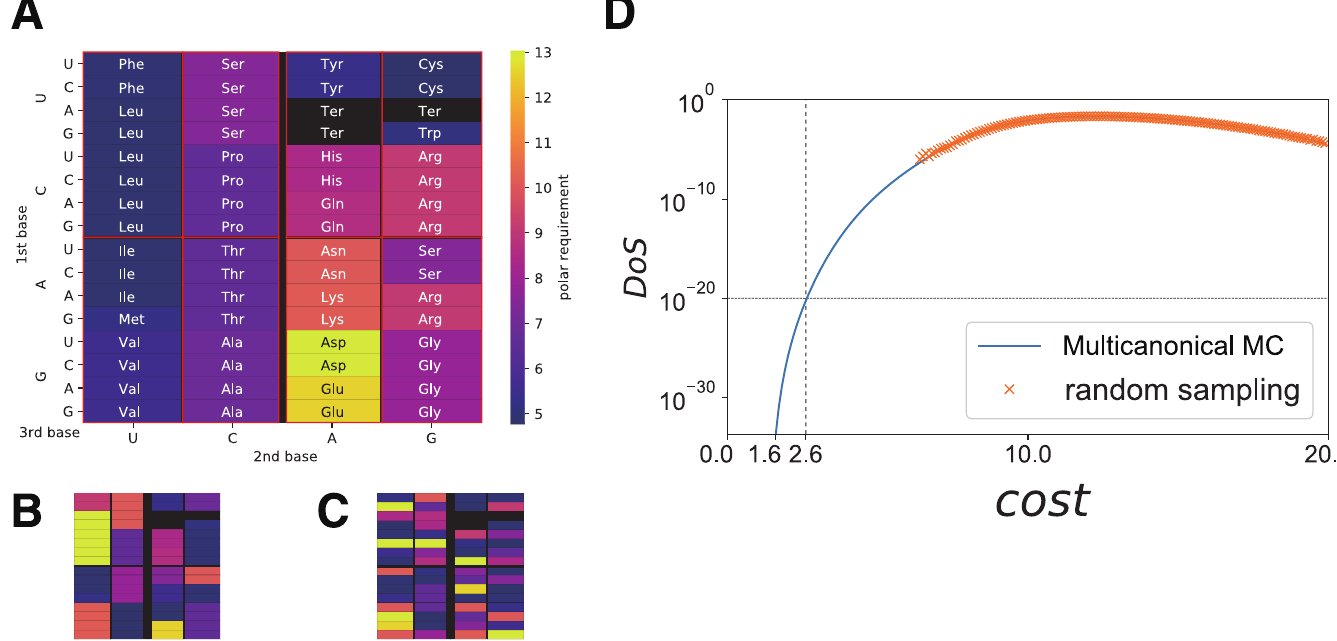
Fig 1. The standard genetic code and randomly generated genetic codes. (A) The standard genetic code. (B) A random genetic code generated from a random ensemble that Haig and Hurst [2] adopted. The block structure in the SGC where the same amino acid is coded is constrained to be maintained in the randomly generated code (see also S2 Fig). (C) A random code generated from a fully random ensemble where each codon maps to any one of 20 amino acids. (D) Cost density-of- states function for the proposed random genetic code ensemble. The blue line represents the estimates by the multicanonical Monte Carlo (multicanonical MC). The orange crosses indicate estimates based on naive random